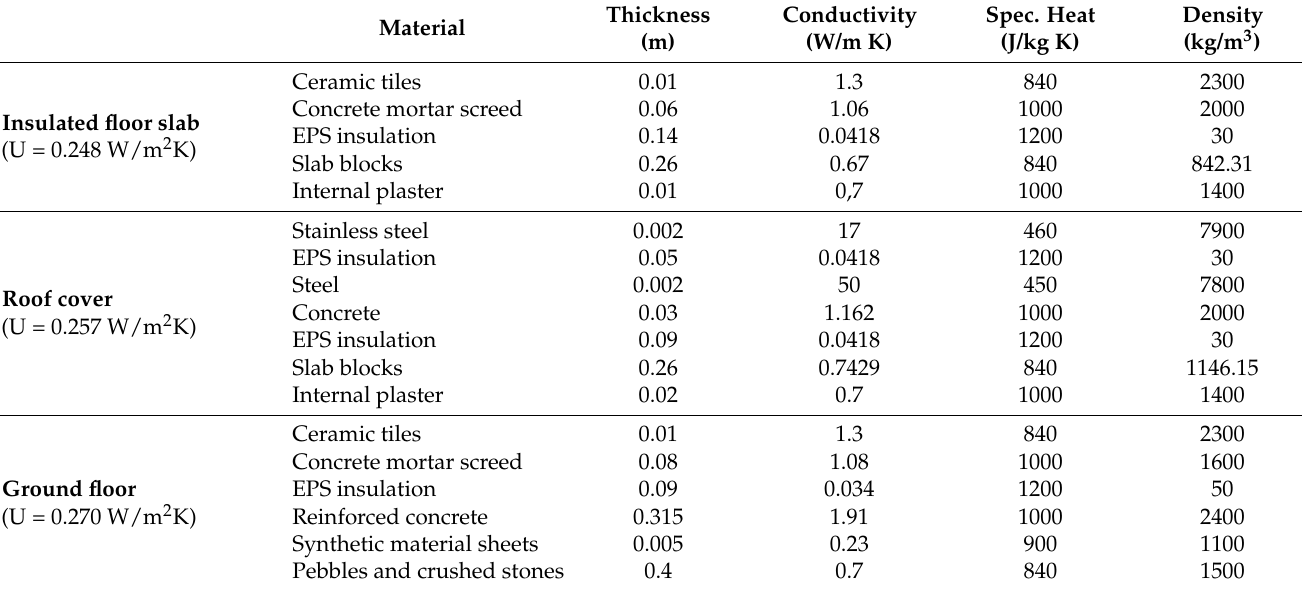
Table 2. Properties of floors and roof layers.